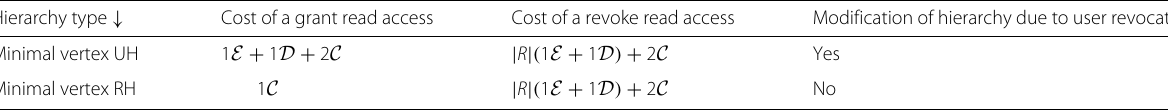
Table 4 Comparison of computation and communication cost Hierarchy type